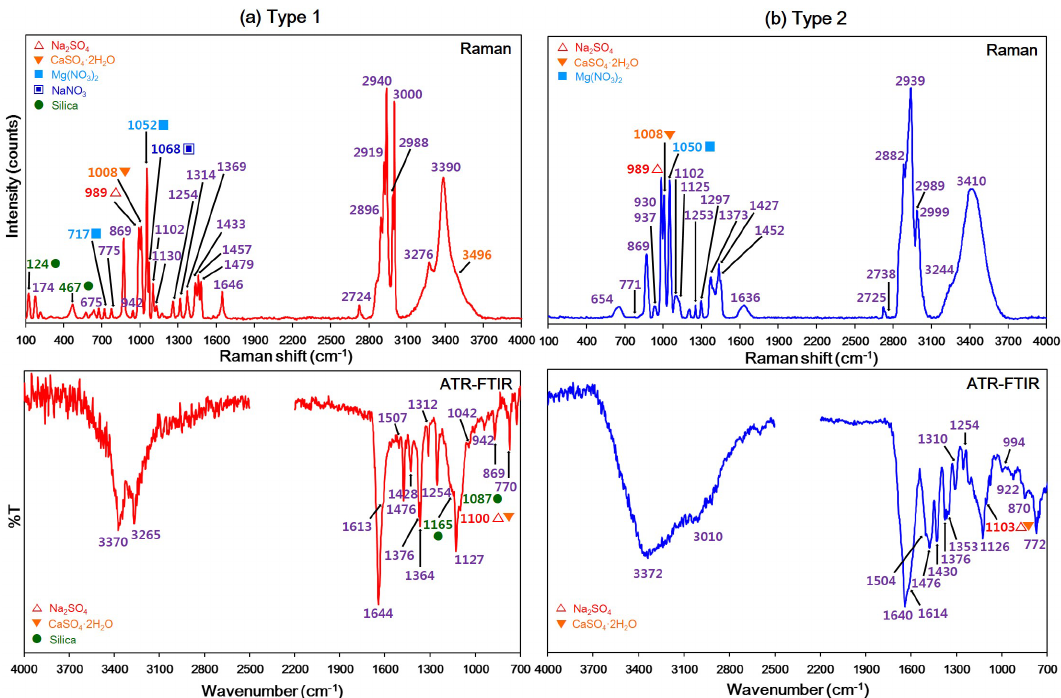
Figure 4. Raman and ATR-FTIR spectra of two typical individual summertime SSAs. The ATR-FTIR data from the 2200–2390cm − 1 region, where the atmospheric CO 2 peaks are present, were deleted for